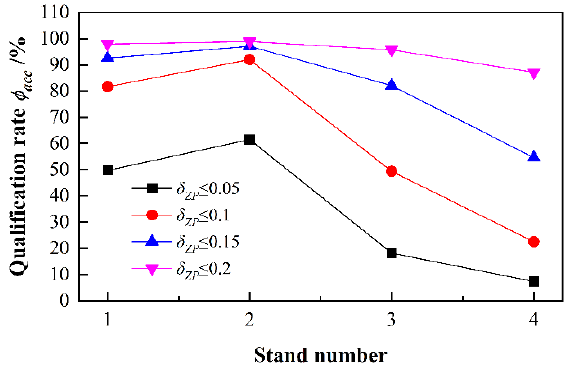
Figure 6. Rolling force qualification rate of each stand.